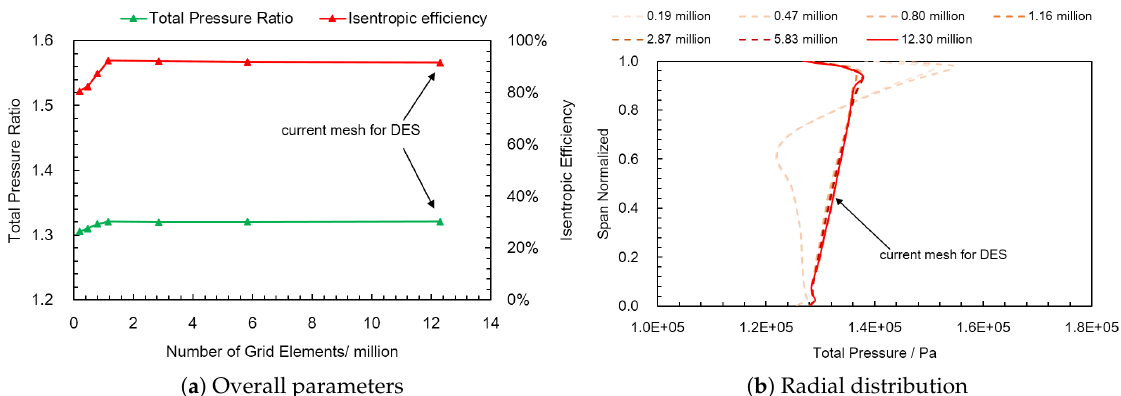
Figure 4. Grid independence study.